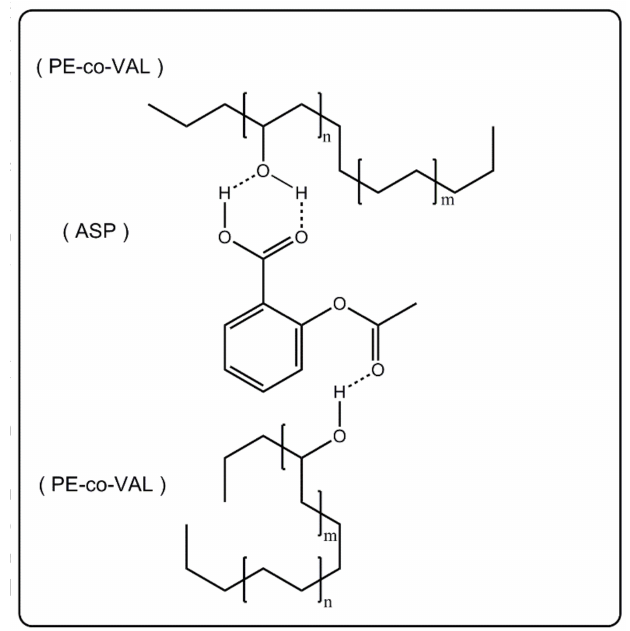
Figure 2. FTIR spectra of ASP and ASP/PE- co -VAL/P δ -VL50 drug carrier systems containing different ASP